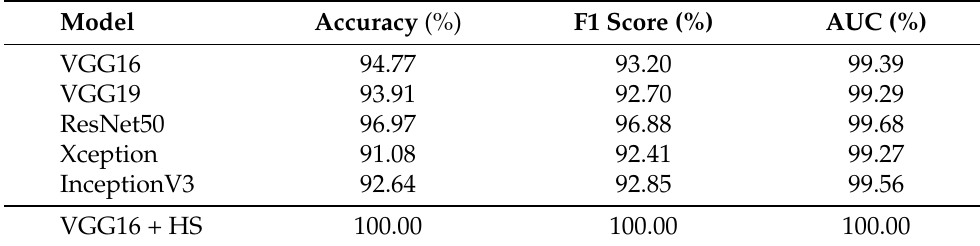
Table 5. A summary of the results obtained by the classifiers on the three-class classification task. The input image was to be classified as normal, pneumonia-affected or